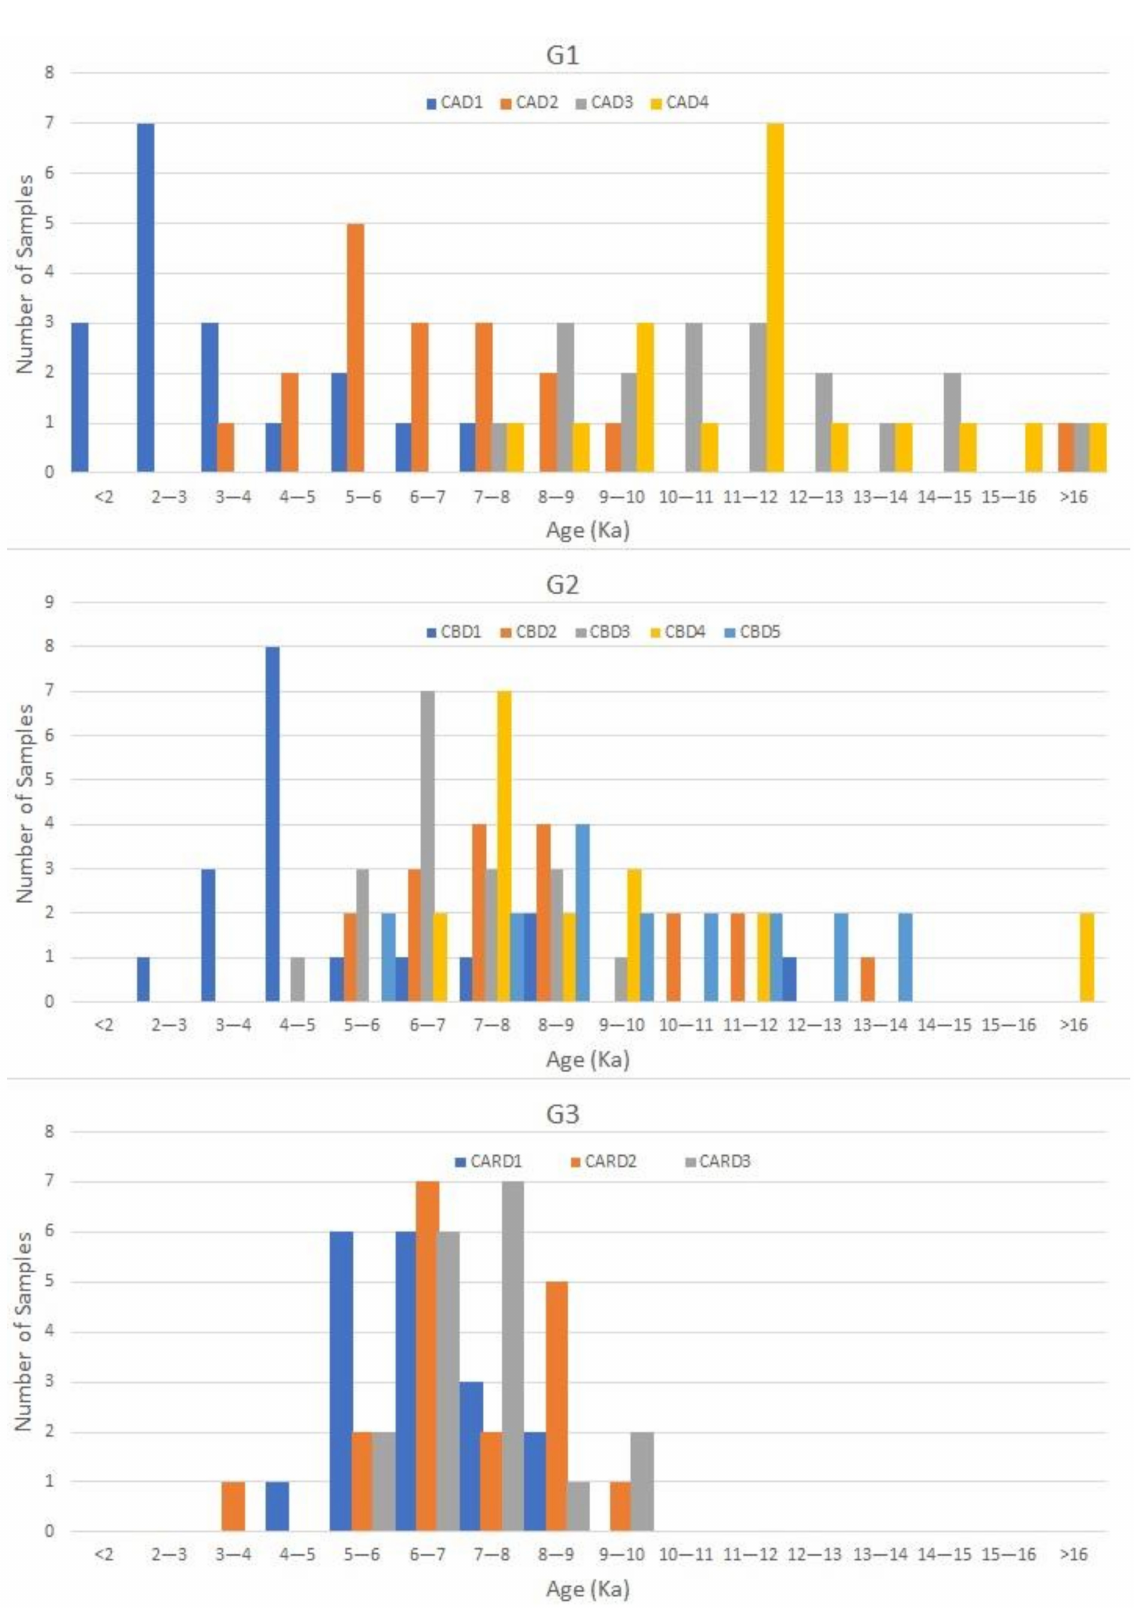
Figure 7. Distribution of the calculated ages (in ka) for the number of